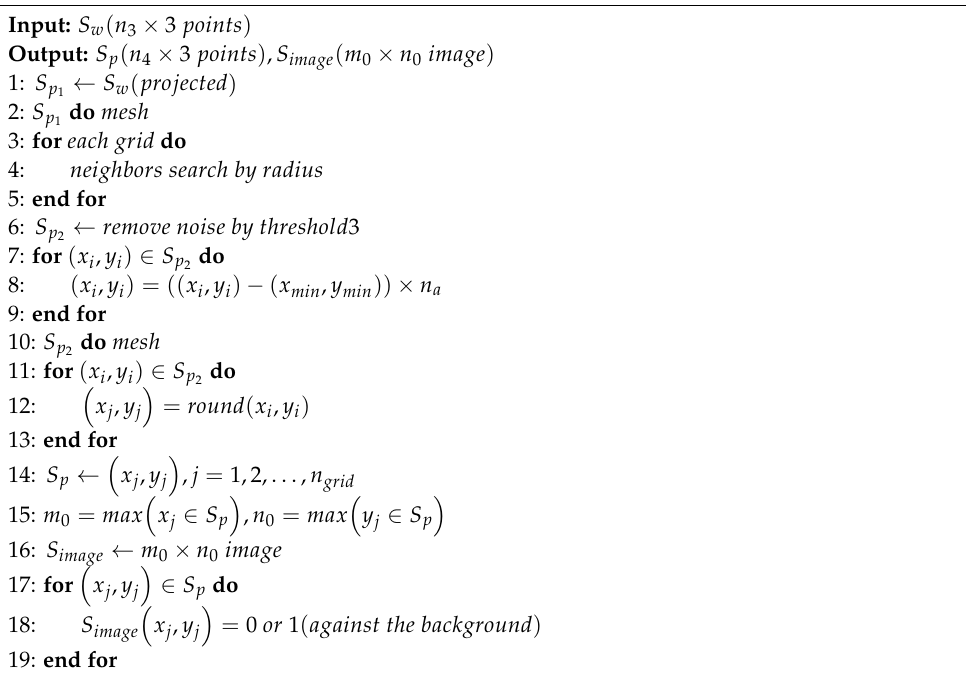
Algorithm 3 Data format conversion